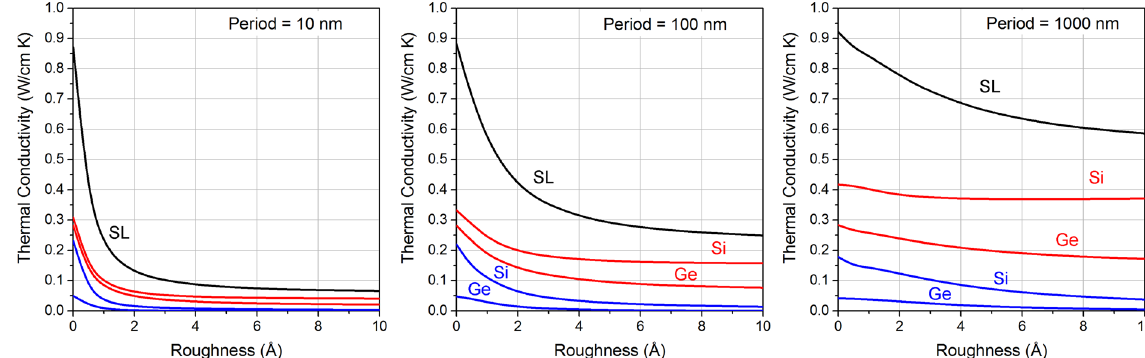
Figure 5. Effects of interface roughness on the amount of heat carried by layer-restricted and extended phonons in superlattices with periods d = 10 nm, 100 nm, and 1000 nm. Black, red and blue curves represent total, layer-restricted and extended components of conductivity